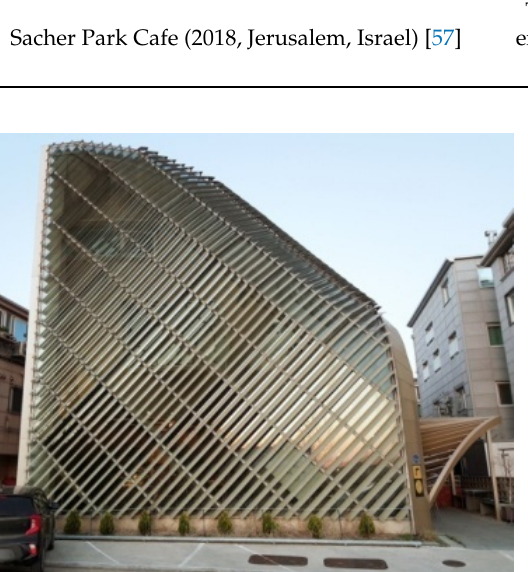
Figure 3. Louverwall (2016, Gyeonggi Province, Korea).